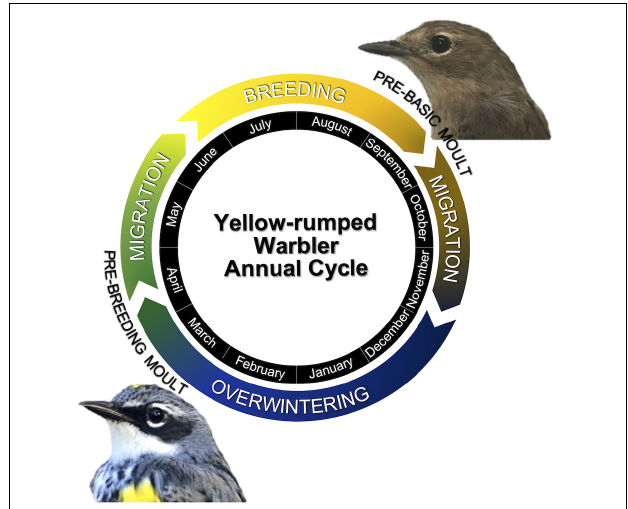
FIGURE 1 | Schematic of the annual cycle of yellow-rumped warblers ( Setophaga coronata coronata ). Pictured is the typical appearance of a yellow-rumped warbler in breeding plumage and in pre-basic (non-breeding)